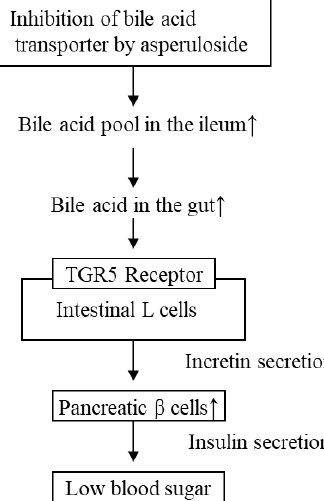
Figure 7. Mechanism of action for the blood sugar lowering effects of ASP. TGR5 Receptor: transmembrane G protein-coupled receptor 5. Small arrows next to words indicate the increases or decreases in the action or secretion.